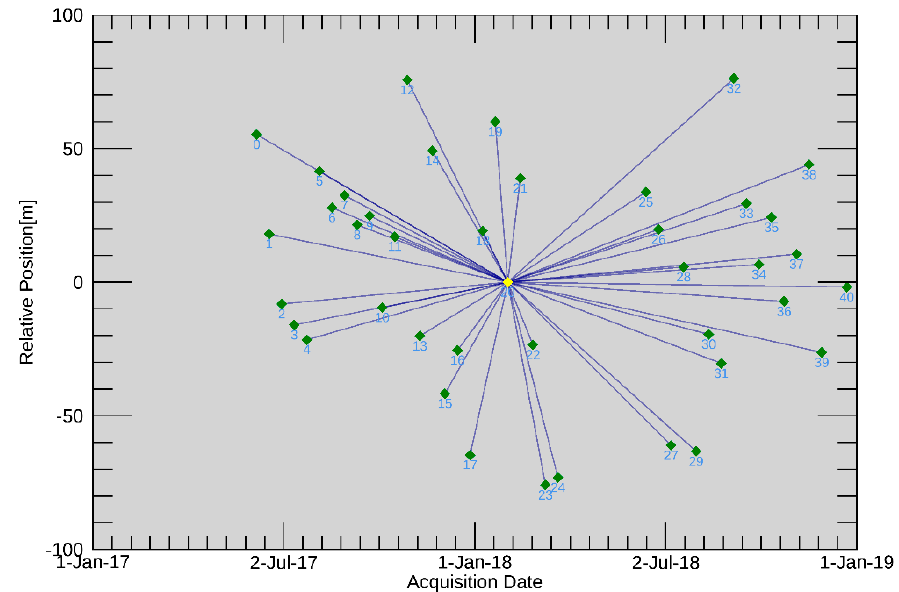
Figure 3. Perpendicular baseline of the interferometric pairs used to identify the PSs versus the acquisition dates of the 41 S1 images of the stack. The yellow diamond indicates the master image; the green diamonds indicate the slaves. The numbers represent an index identifying each image of the stack.